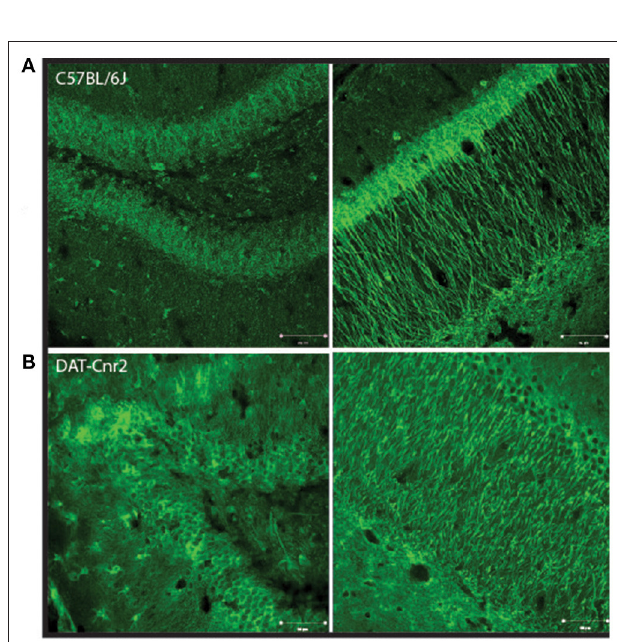
FIGURE 9 | Representative images of Cd11b staining in dentate gyrus left and cornu amonis 1 (Right) regions of the hippocampus in male C57BL/6J (A) and DAT- Cnr2 cKO (B) male mice. Cd11b immunofluorescence (green).